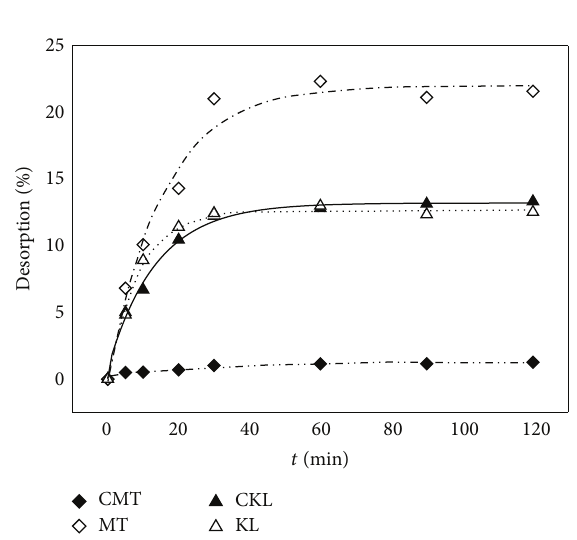
Figure 9: Desorption plot of pyrene from the bare clays and their complexes at 298